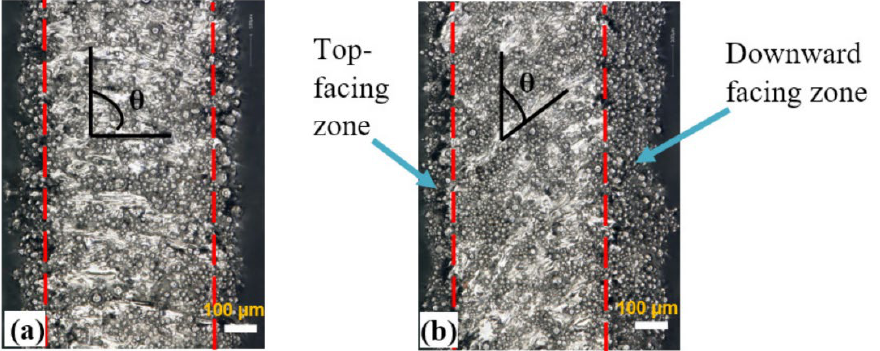
Figure 8. The optical microscope images of: ( a ) vertical strut (θ = 90°), and ( b ) inclined strut (θ = 40°). Zones between the red dotted lines represent the fully melted portion of the struts.